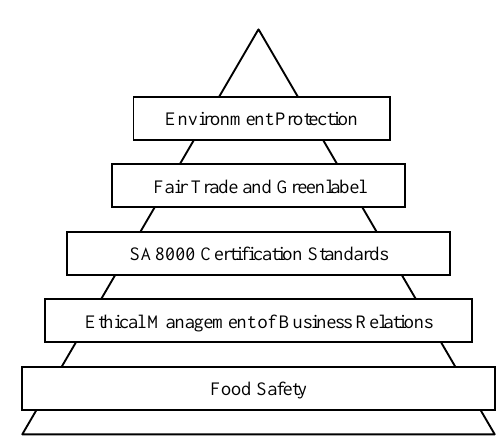
Figure 1: From Quality to